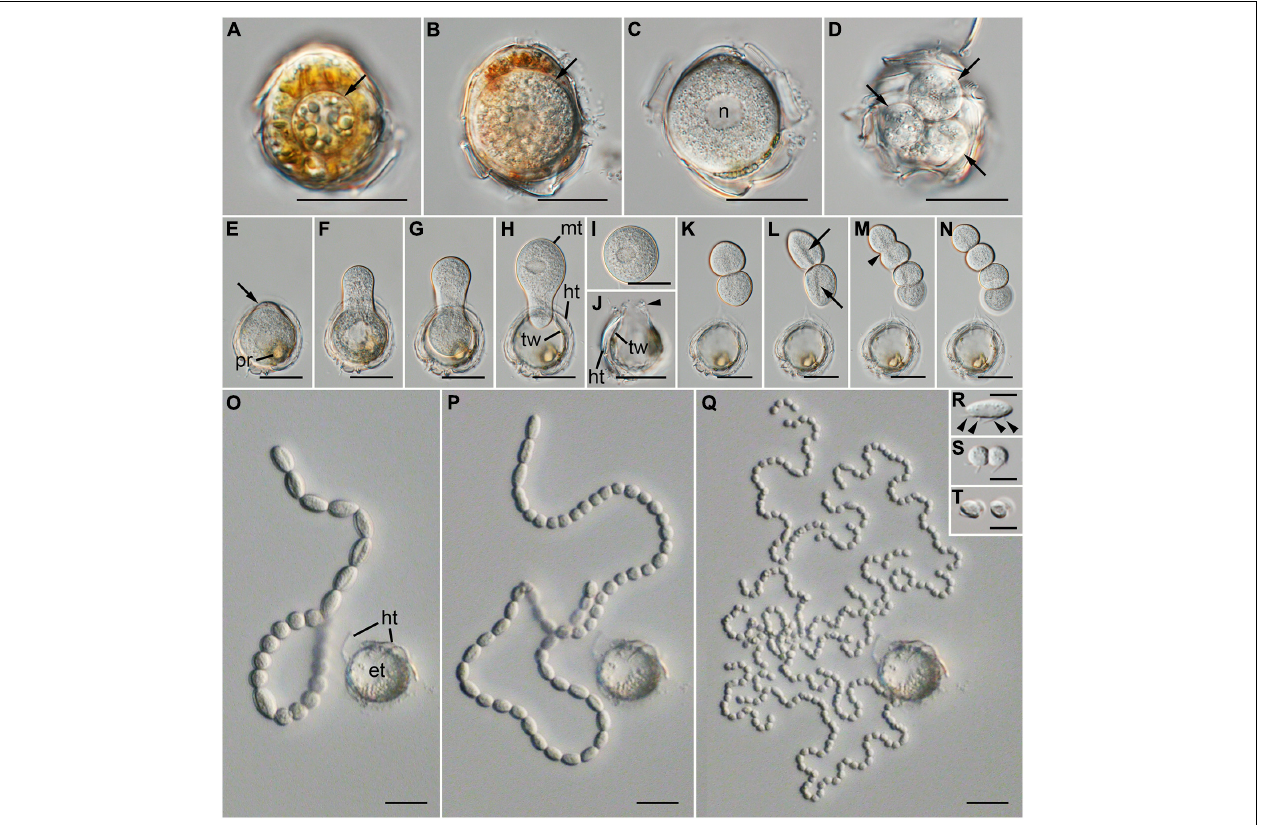
FIGURE 1 | Differential interference contrast (DIC) images showing the life-cycle stages of Pararosarium dinoexitiosum gen. nov. et sp. nov. in the dinoflagellate host Alexandrium pacificum . (A) Early trophocyte (arrow) within host cytoplasm. (B) Growing trophocyte (arrow) consuming the host cytoplasmic contents. (C) Late trophocyte with a large nucleus (n). (D) Multiple infection showing three trophocytes (arrows) within a single host cell. (E) Wall of late trophocyte showing a bulge (arrow) with plastid remnants (pr) of host (F–H) Emergence of the mature trophocyte (mt) from the late trophocyte wall (tw). Theca remnants (ht) of host is also shown. (I) Complete emergence of a mature trophocyte. (J) Empty trophocyte with the mark of a mature trophocyte emerging (arrowhead), late trophocyte wall (tw), and theca remnants (ht) of host. (K) Two completely divided sporocytes. (L) Two sporocytes showing a long transversal groove (arrows) on the central surface. (M) Invagination (arrowhead) of the sporocytes during cytokinesis. (N) Four completely divided sporocytes. (O–Q) Progressive sporogenesis stages during the development of beaded sporocytes, resembling a rosary, with theca remnants (ht) of the host and empty trophocyte wall (et) of the parasitoid. (R) Sporocyte before the last division with four flagella (arrowheads). (S) Two completely divided immature zoospores with round body shape. (T) Sigmoid-shaped immature zoospores. Scale bars: (A–Q) = 20 µ m, (R–T) = 5 µ